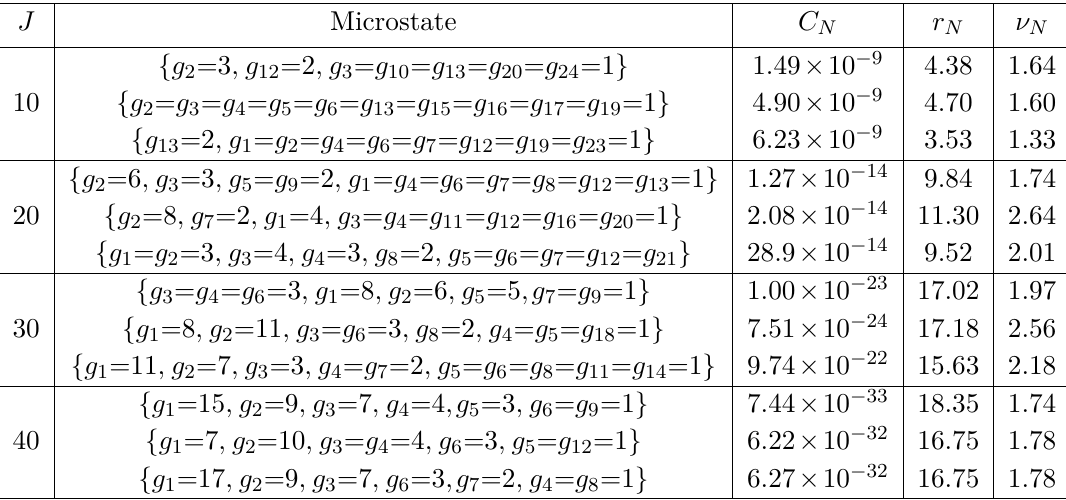
JHEP04(2023)052